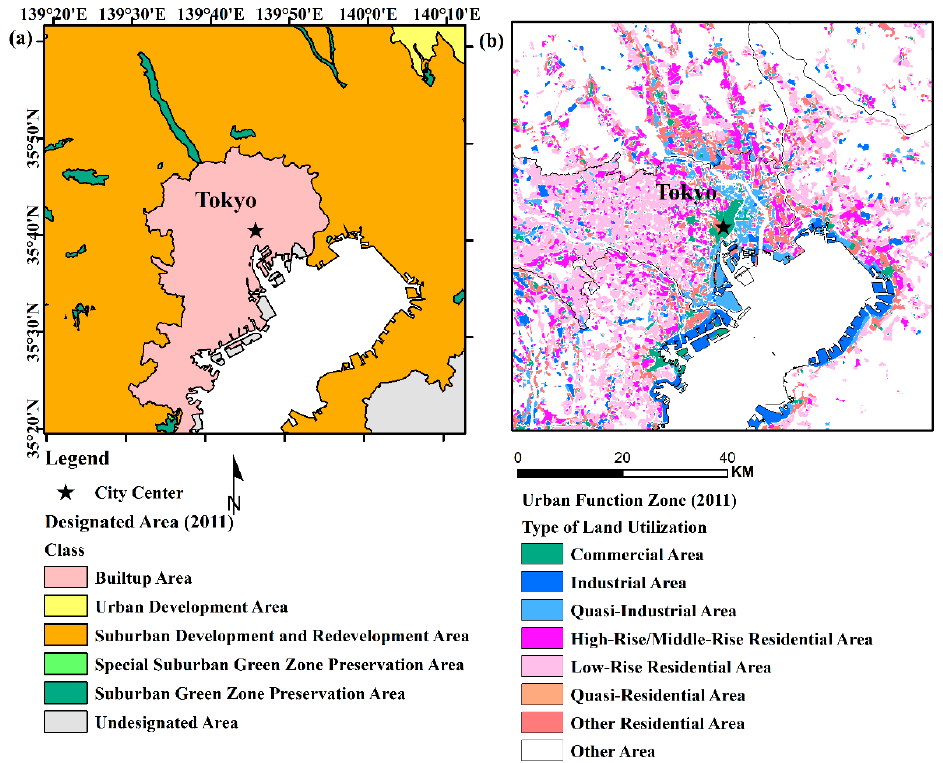
Figure 11. Land utilization and function of TMA in 2011: ( a ) policy areas and ( b ) urban land utilization. Data obtained from National Land Numerical Information Download Service, Ministry of Land, Infrastructure, Transport, and Tourism, Japan (https://nlftp.mlit.go.jp/ksj/index.html).